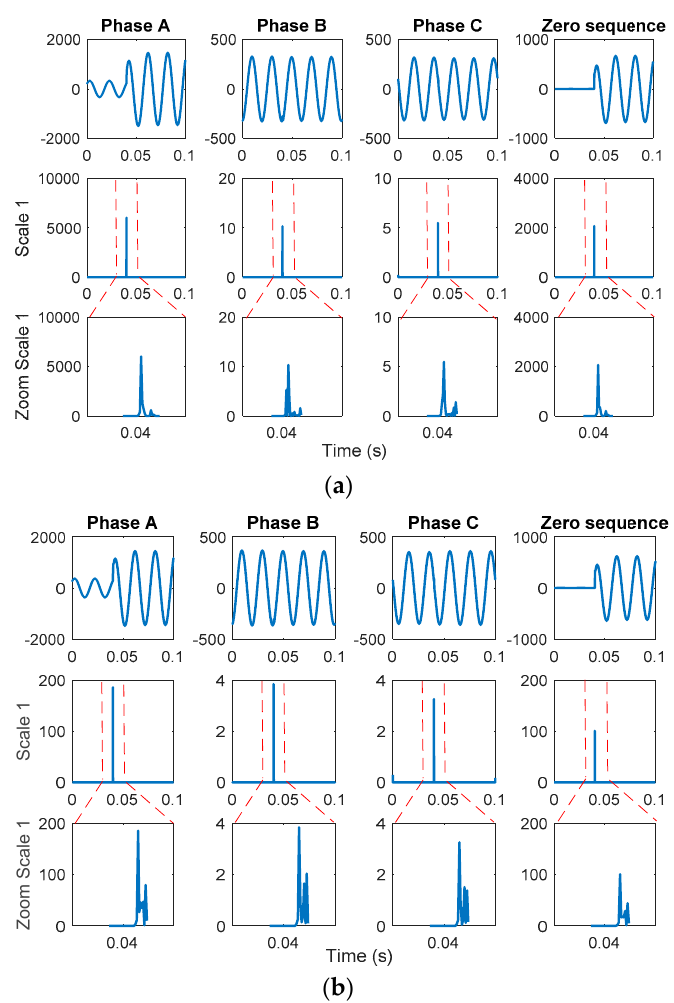
Figure 4. Signals from the wavelet transform (WT) in the case of phase A, short circuit to ground fault at 30% of the length of the transmission line: ( a ) sending end; ( b ) receiving end.